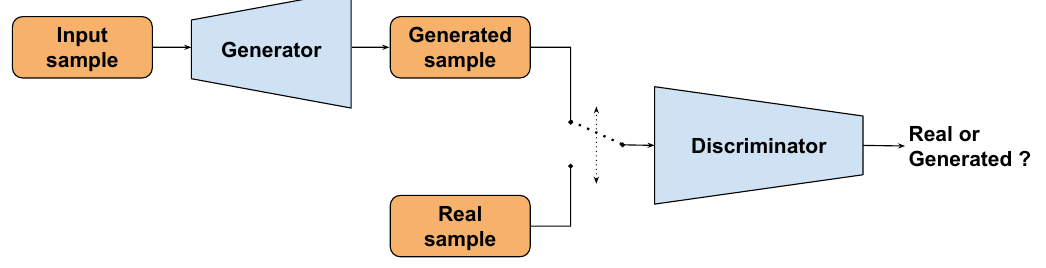
Figure 3. General scheme of a Generative Adversarial